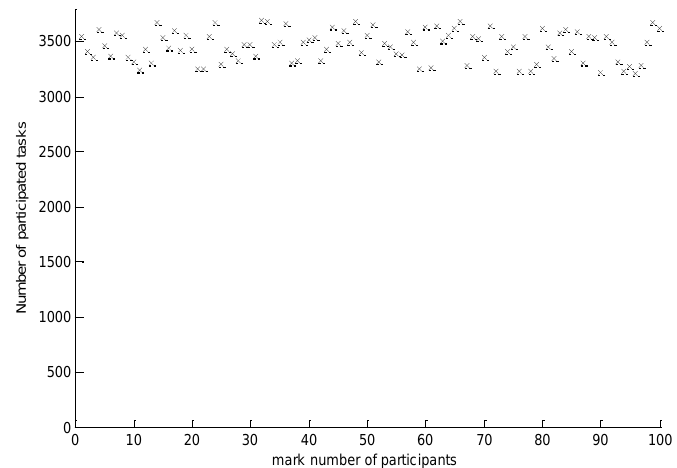
Figure 5. Number of participated tasks for each participant within 8 days.